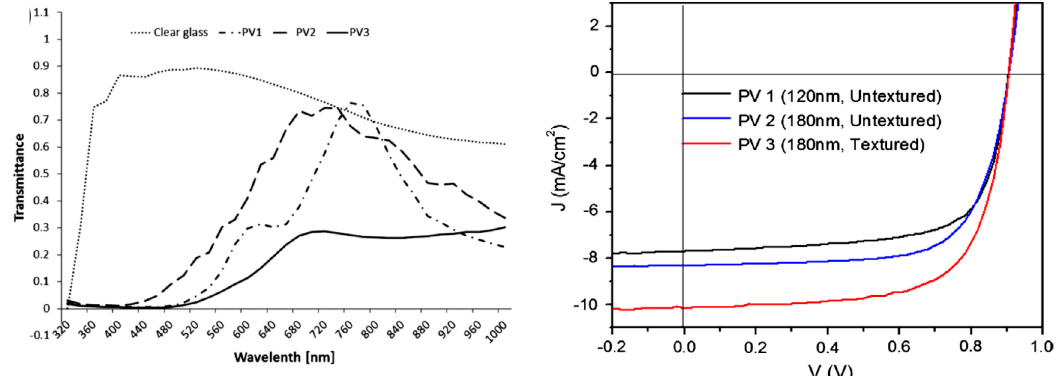
Figure 2. Transmission spectrum of semi-transparent devices with different absorption layers (left), and J-V characteristic curve for semi-transparent devices (right). Reprinted from Applied Energy, Volume 129, Y. T. Chae et al., Building energy performance evaluation of building integrated photovoltaic (BIPV) window with semi-transparent solar cells, Pages 217–227, Copyright (2014), with permission from Elsevier.